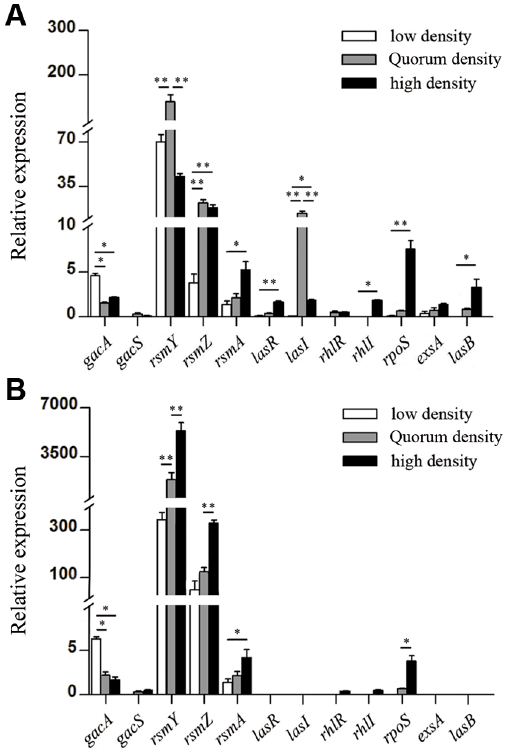
Figure 2. GacA-RsmYZ leadership cascade governs the initial expression of the QS-dependent genes. Gene expression of leadership and QS regulators in WT PAO1 (A) and QS-deficient strain PAO1- D lasR (B) in low density (OD 600 < 0.12), quorum density (OD 600 < 0.28), and high density (OD 600 < 0.9) phases. Data are means 6 standard error means (SEM), and representative of three experiments. *, P , 0.01; **, P , 0.001, one-way ANOVA (Tukey-Kramer post hoc).